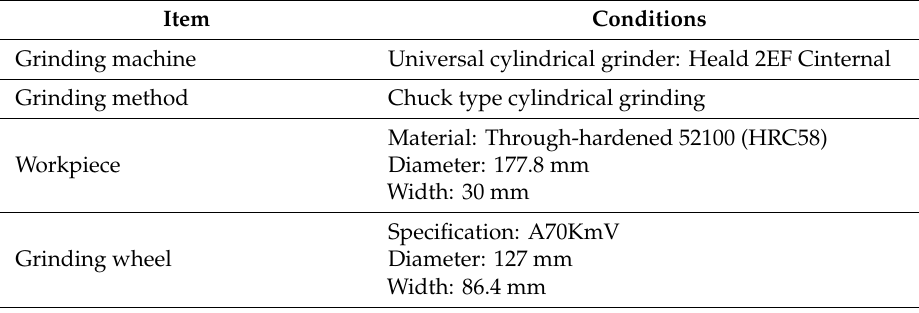
Table 6. Grinding conditions of plunge cylindrical grinding.